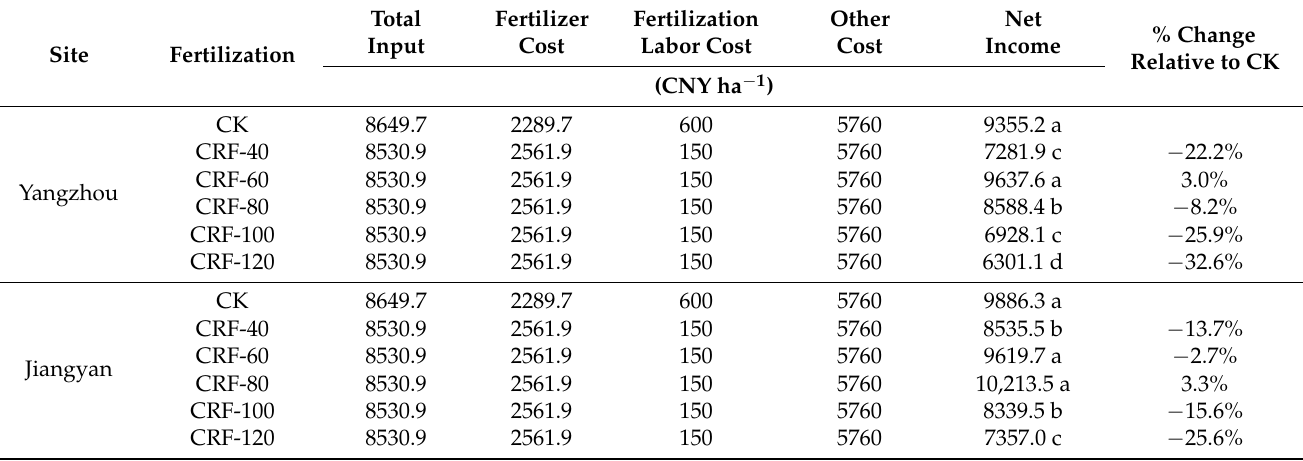
Table 7. Economic evaluation of wheat production with different fertilizer treatments in Yangzhou and Jiangyan (Averages for two wheat varieties over two